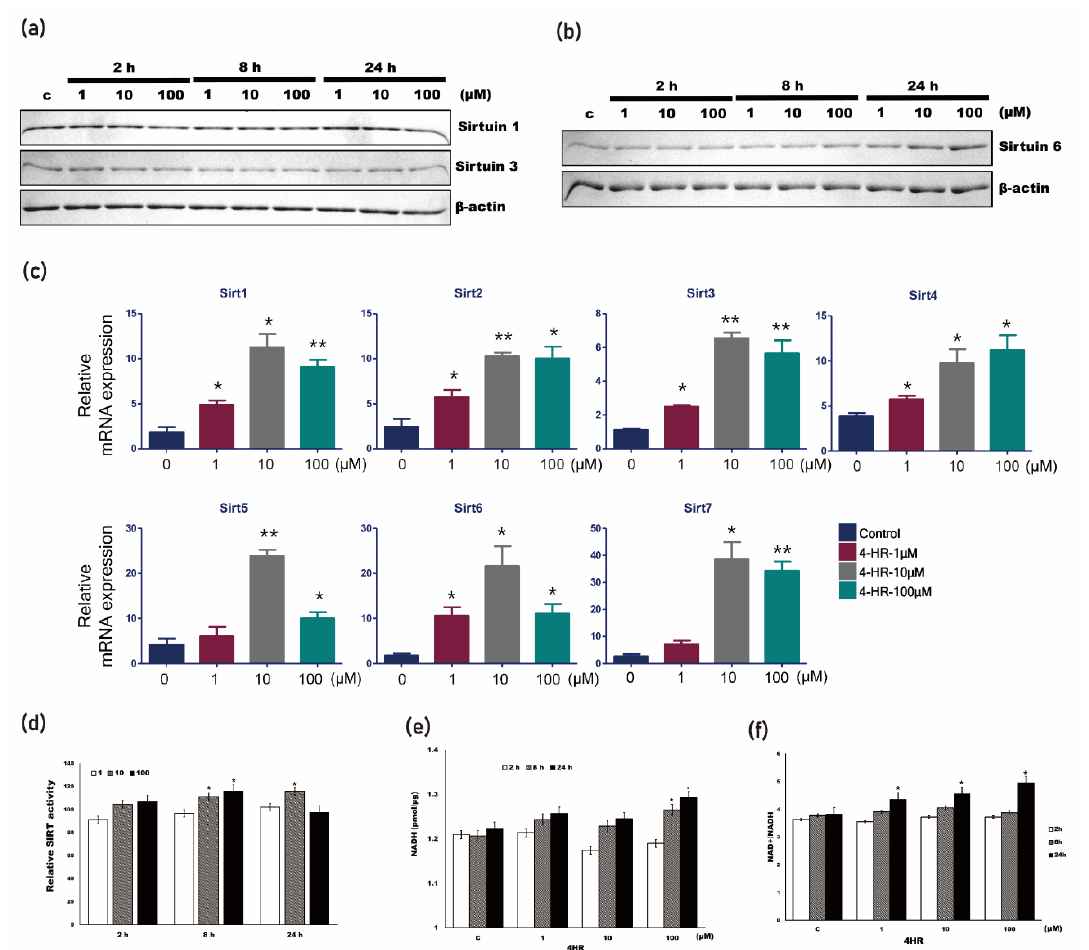
Figure 5. 4HR administration and SIRT expression. ( a ) The administration of 4HR did not change the expression of SIRT1 and SIRT3 in HUVECs. ( b ) The administration of 4HR increased the expression of SIRT6 in HUVECs. ( c ) Quantitative RT-PCR results showed that the SIRTs mRNA expression level was significantly increased by 4HR administration (* p < 0.05, ** p < 0.01 compared to untreated control). ( d ) The administration of 4HR (1–100 μ M) increased pan-SIRTs enzyme activity (* p < 0.05 compared to the control group). ( e ) The administration of 4HR increased NAD+ production (* p < 0.05 compared to the control group). ( f ) 4HR also increased the NAD+/NADH ratio (* p < 0.05 compared to the control group). All blots were performed in triplicate, and the statistical analysis of the relative expression level is shown in Supplementary Figure S8.